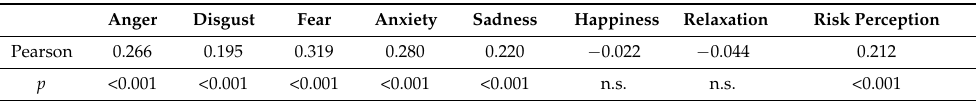
Table 4. Pearson correlation between headache intensity and emotions and perception of risk related to pandemic in 304 migraine